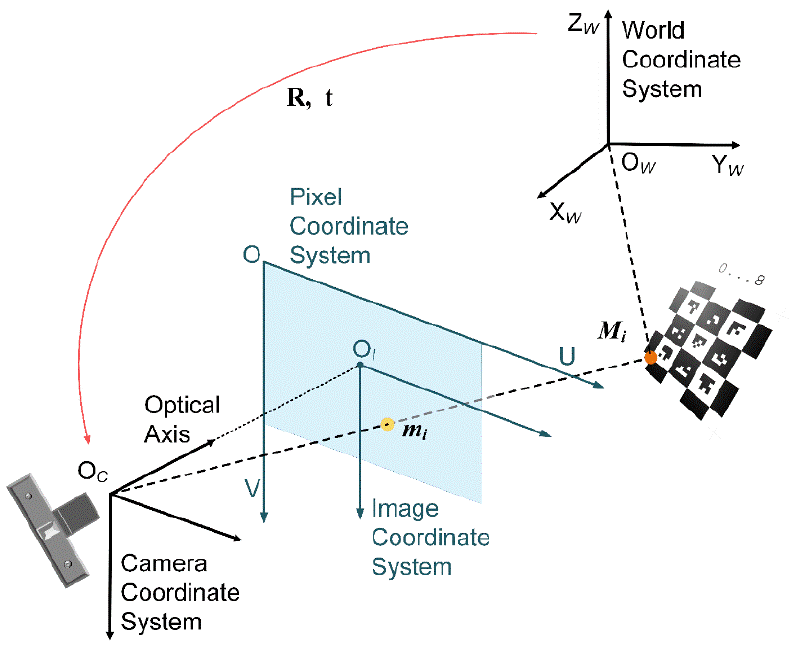
Figure 3. Camera